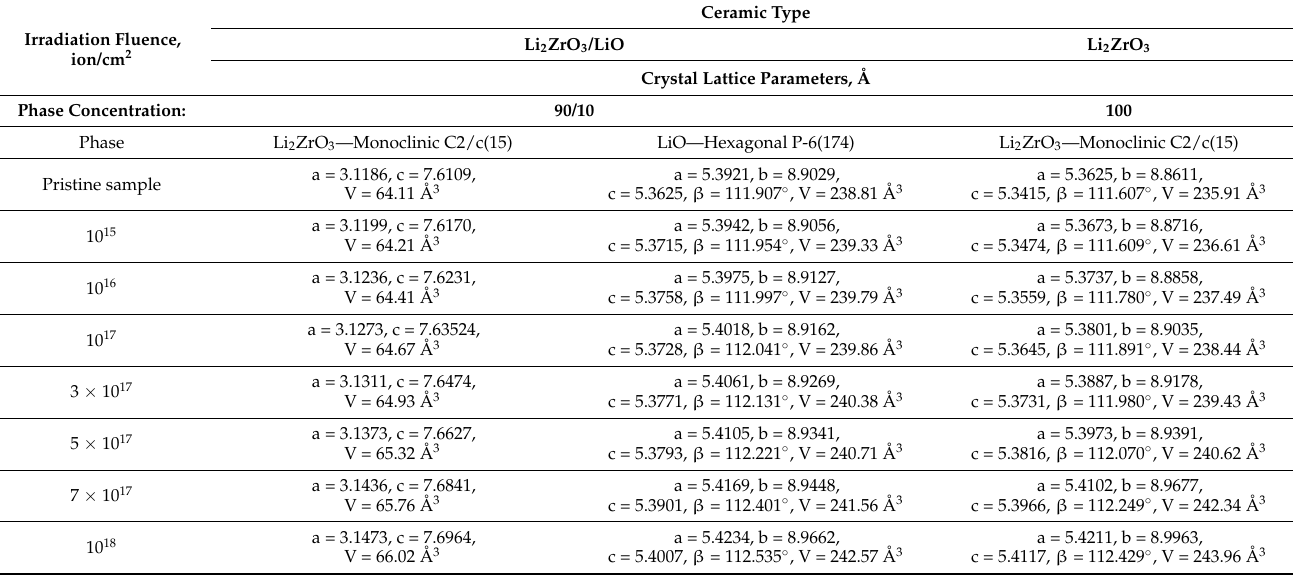
Table 1. Data of structural parameters of the crystal